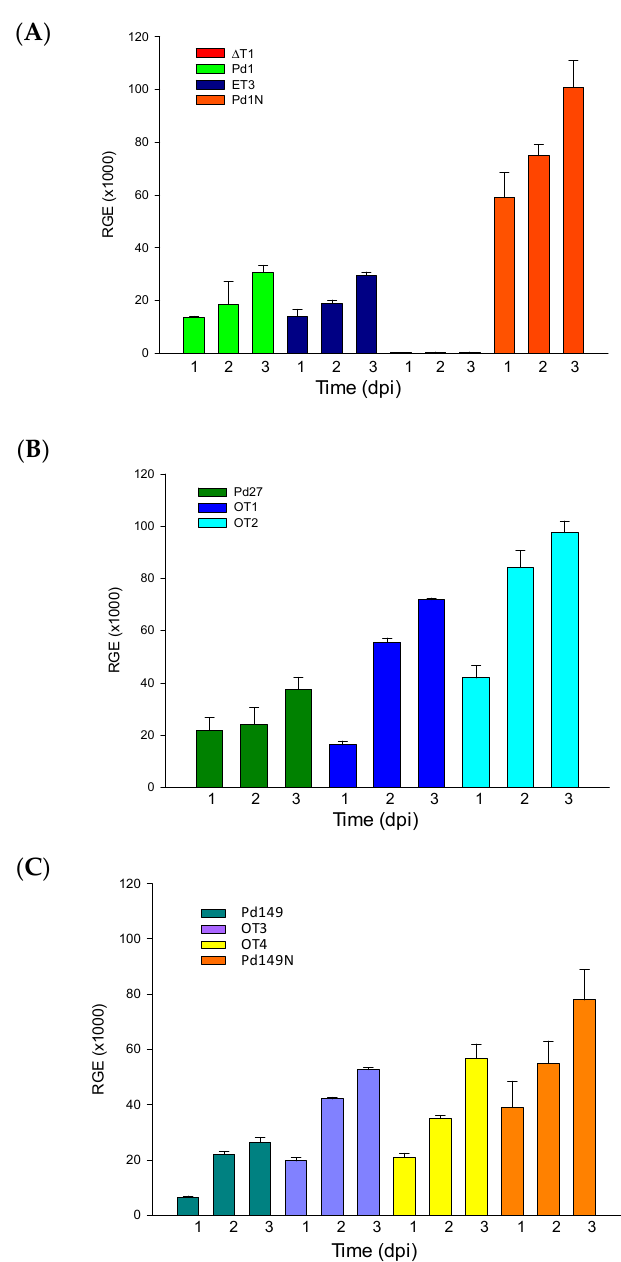
Figure 8. Analysis of PdMFS1 relative gene expression (RGE). ( A ) Time course evaluation of gene expression of Pd1 and deletant mutants in PDB liquid culture at 25 °C (Pd1, Δ T1, ET3) and during orange infection (Pd1N). ( B ) Time course evaluation of gene expression of Pd27 and overexpression transformants in PDB liquid culture at 25 °C. ( C ) Time course evaluation of gene expression of Pd149 and overexpression mutants in PDB liquid culture at 25 °C (Pd149, OT3, OT4) and during orange infection (Pd149N). In all cases: 1, 2 and 3 correspond to 1, 2 and 3 dpi, respectively. The expression levels are relative to three reference genes: ribosomal 28S RNA, β -tubulin and histone H3. Error bars indicate standard deviations of three biological replicates.